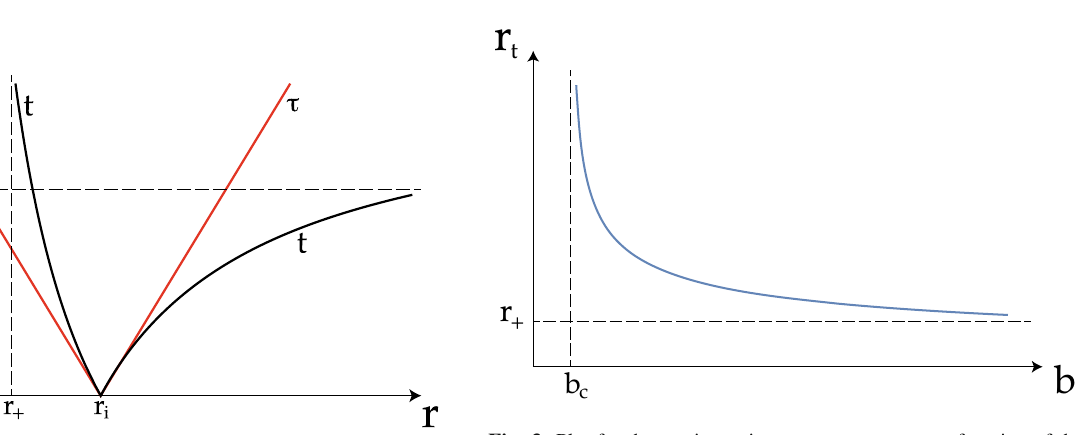
Fig. 2 Temporal null geodesics for radial motion described by Eqs. (22) and (23). This shows some equivalence with its spherical counter- part previously studied by Cruz et al. [21] for photons moving to r + . The novel result appears for photons moving to infinity in which, as is measured by an observer in r i , it takes a finite coordinate time t ∞ to reach infinity. This feature was reported before by Villanueva and Vásquez but in the context of Lifshitz space-times [44]